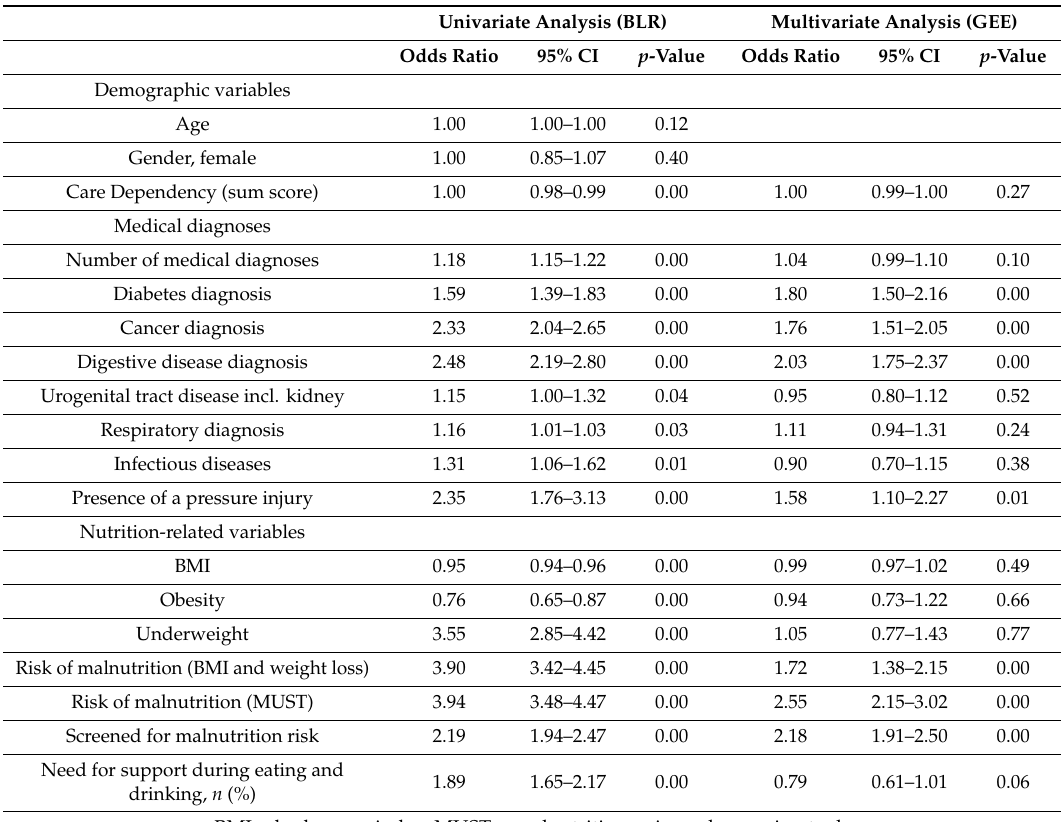
Table 2. Predictors for dietitian referral, univariate binary logistic regression (BLR), and multivariate generalized estimating equation model